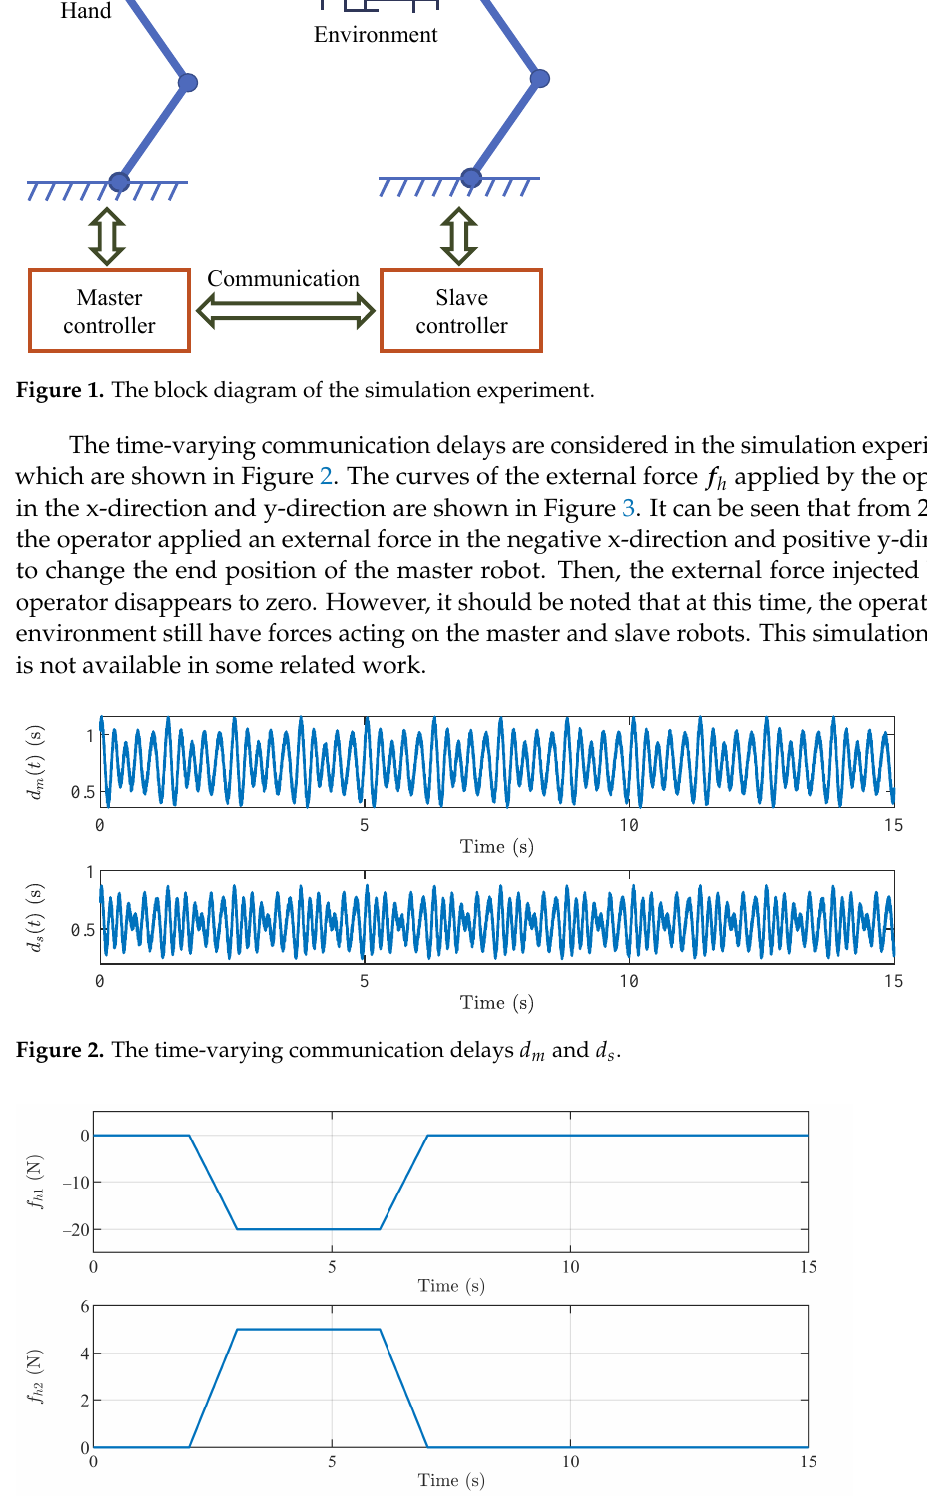
Figure 3. External operator forces f h